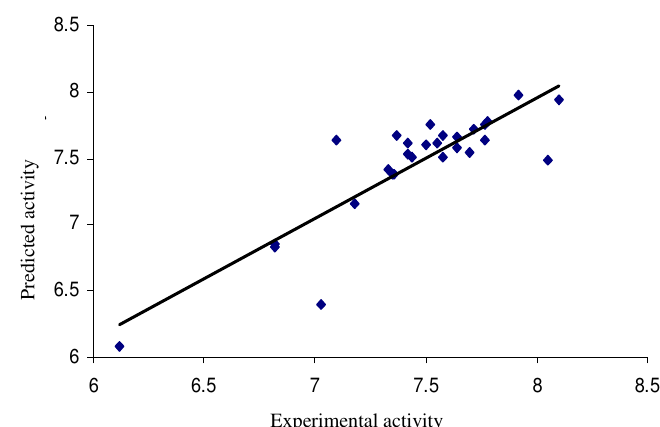
Figure 3. Plot of p IC